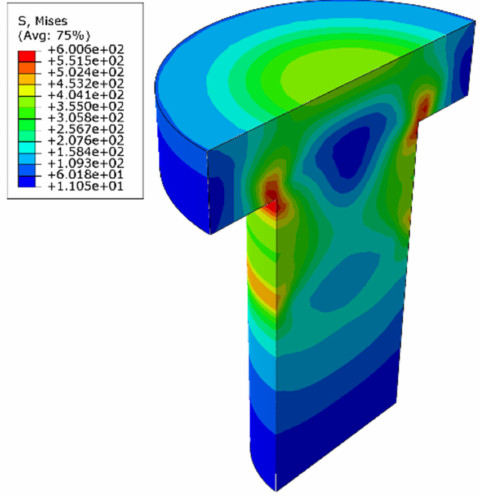
Figure 10. The stress distribution of the bolt with 3.2% interference.